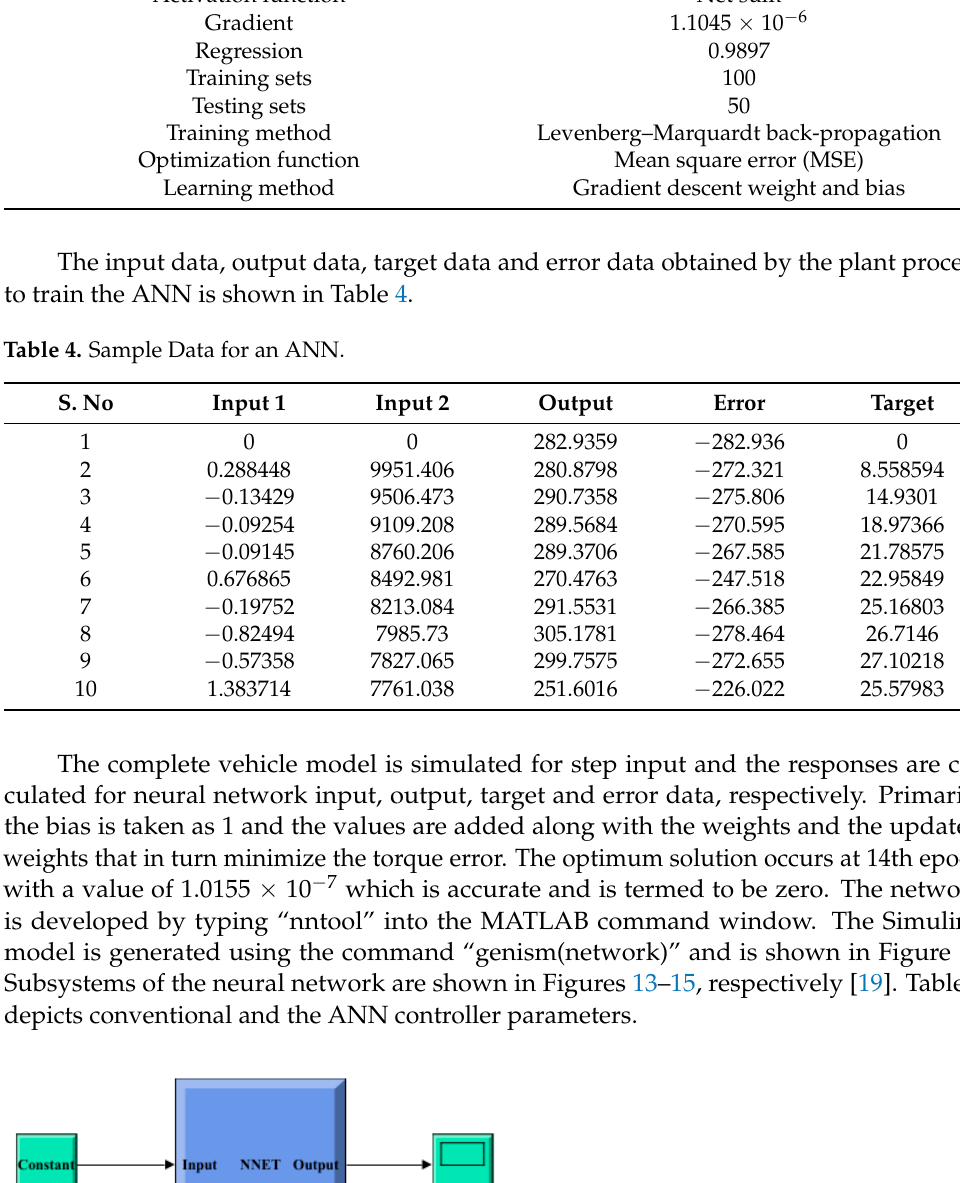
Figure 13. Subsystem of an ANN. Figure 14. Subsystem of Layer 1 of an ANN. Figure 15. Subsystem of Layer 2 of an ANN. 5. Simulation Analysis of an eCAR The MATLAB Simulink model of a direct torque controlled eCAR propulsion system was developed using the “Powertrain toolbox” R2019b version and is shown in Figure 16. The Simulink model of a lithium-ion battery, a three phase induction motor, a glider model, gear transmission and voltage source inverter are modelled using their mathemat- ical relations as discussed in Section 2. The developed model is simulated under European Cycle (ECE-R15), High Way Fuel Economy Test (HWFET) and New York City Cycle (NYCC) drive cycles to validate the performance of the proposed ANN tuned torque con- troller and the improvement in the performance of an eCAR is observed. The obtained simulation results for the proposed ANN tuned torque controller are compared with the conventional PI controller and are shown in the following waveforms. Figure 16. Simulink model of an ANN based direct torque controlled eCAR propulsion system.